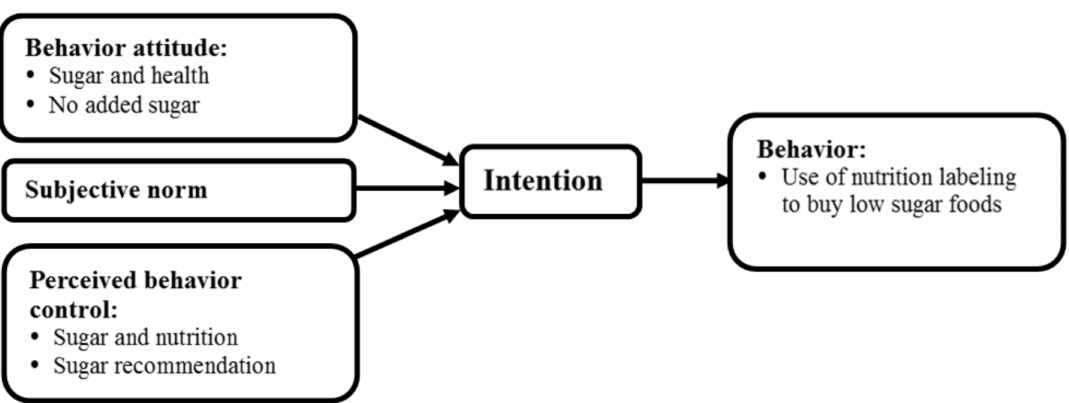
Figure 2. Intervention